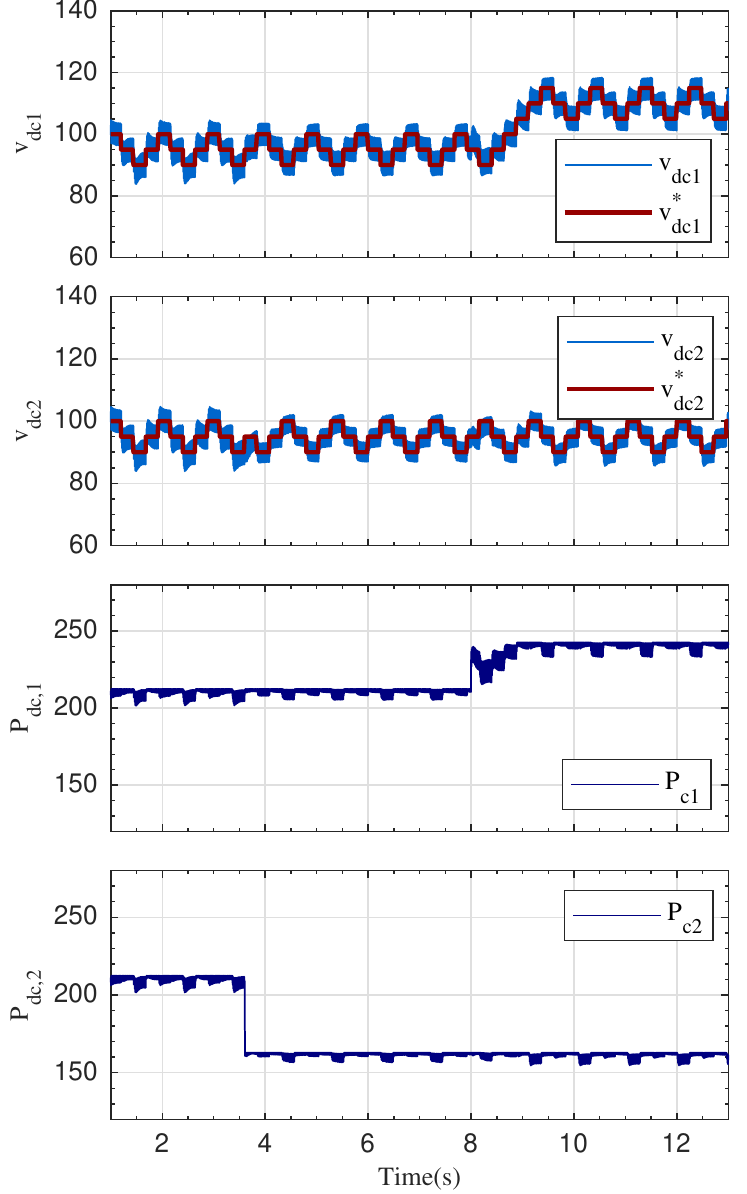
Figure 9. Dynamic operation of DC-link and power on the DC-side under unbalanced power per